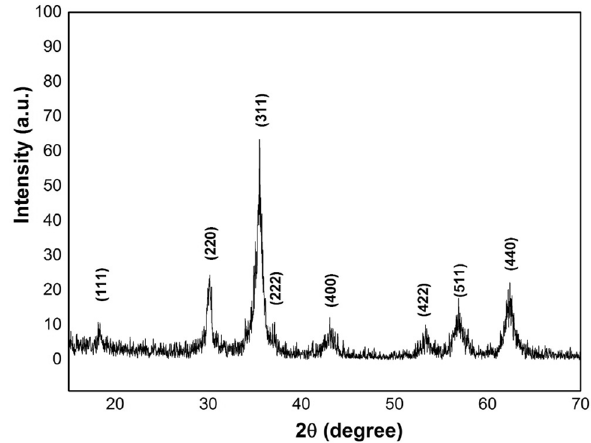
Fig. 2 XRD of the synthesized Mn M_H loop as an